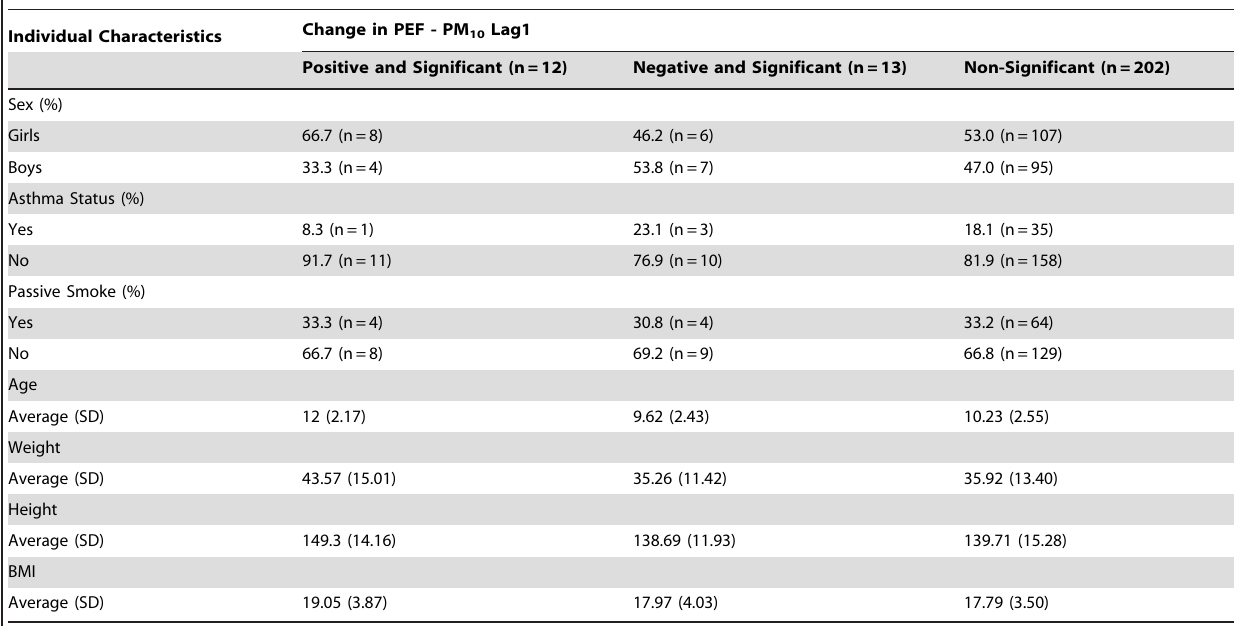
Table 3. Characteristics of the schoolchildren according to the results of the AR(1) estimated model.